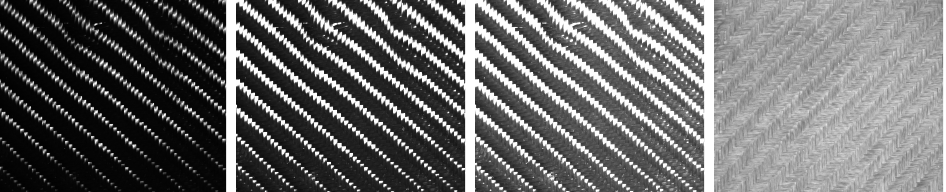
Figure 5. Three images of the identical dry woven sample in ambient lighting at different exposures (40 ms, 200 ms and 500 ms) and one under the dome illuminator (5 ms exposure). N.B. The image under the dome light is of a different part of the sample for practical reasons.